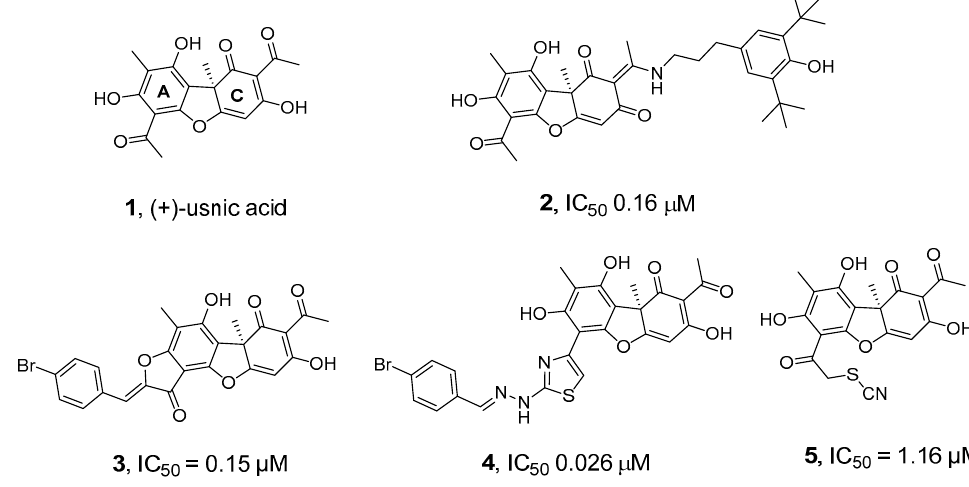
Figure 1. Structures of usnic acid ( 1 ) and its derivatives ( 2 – 5 ) that inhibit TDP1 [32–36].